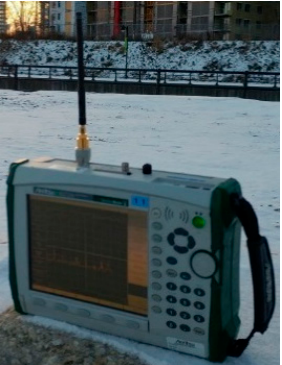
Figure 8. Measurement setup of the ambient noise.